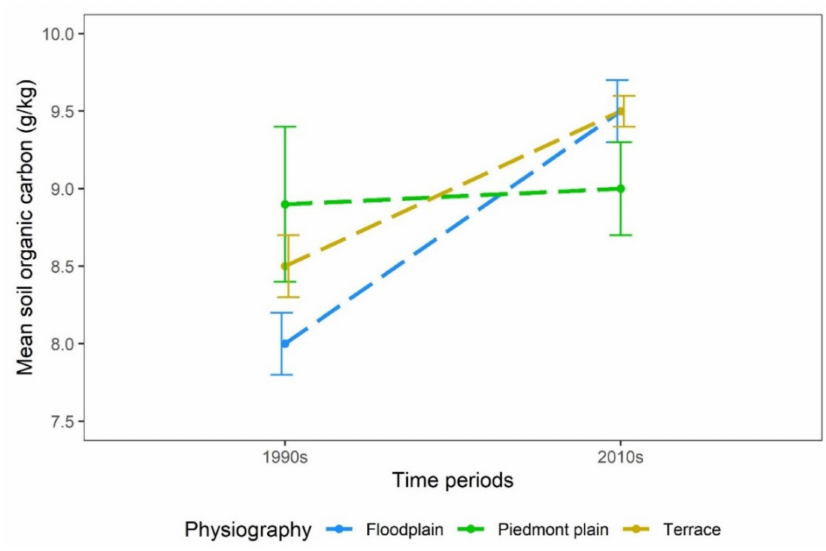
Figure 3. The effect of soil sample collection period (1990s, 2010s) on SOC contents (0–15 cm) in the Floodplain, Piedmont plain and Terrace physiography.